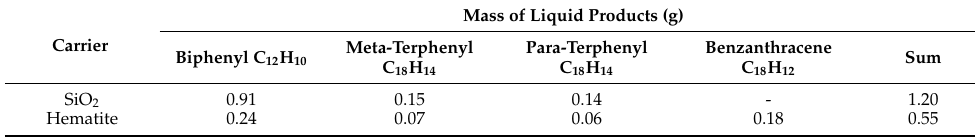
Table 3. Distribution of liquid products during benzene cracked by two carriers.